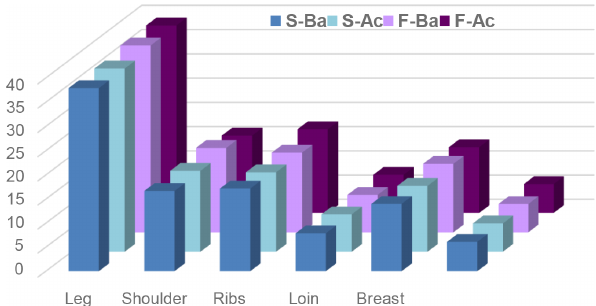
Figure 1. Proportion of joints in the untailed carcasses of lambs